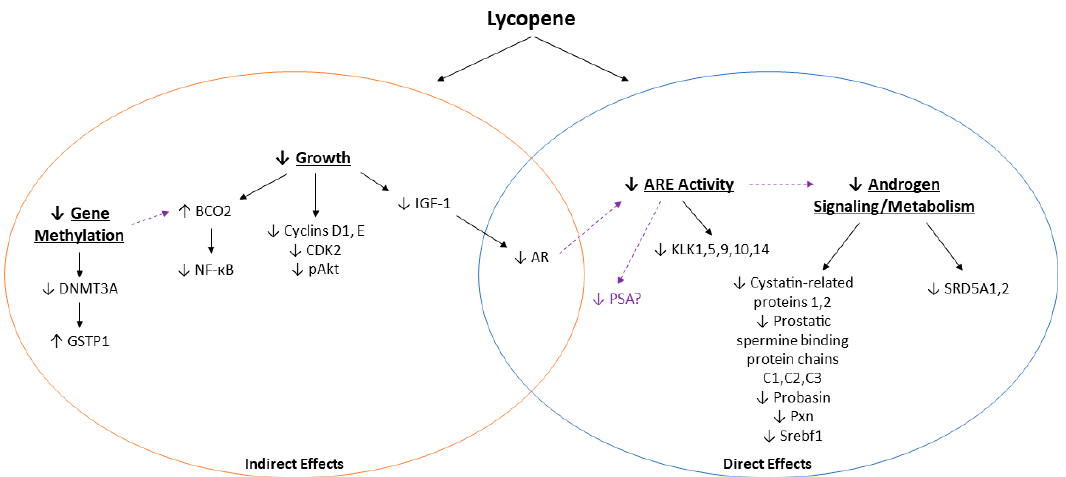
Figure 4. Summary of potential mechanisms by which lycopene may interact with the androgen axis in PCa. Solid lines represent outcomes reported by the reviewed studies, and dashed lines represent potential connections.